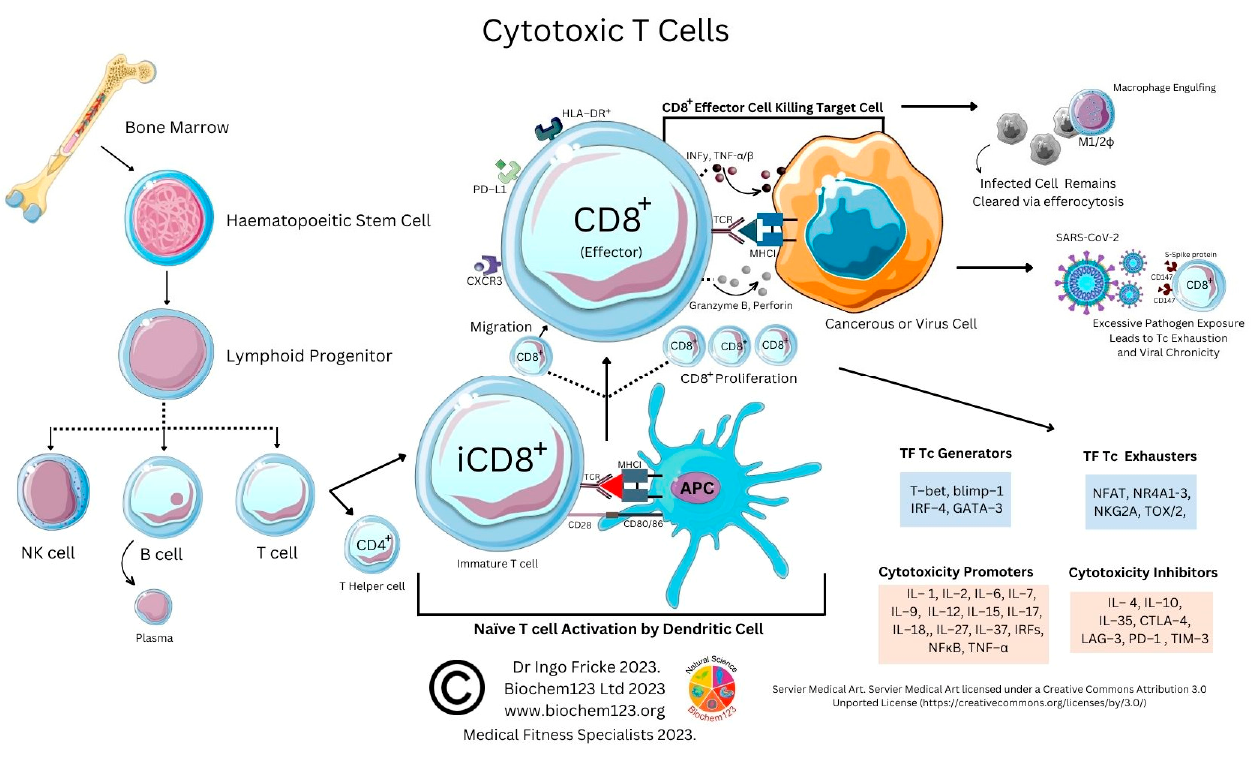
Figure 12. T cell phenotype diversity and developmental cellular markers.